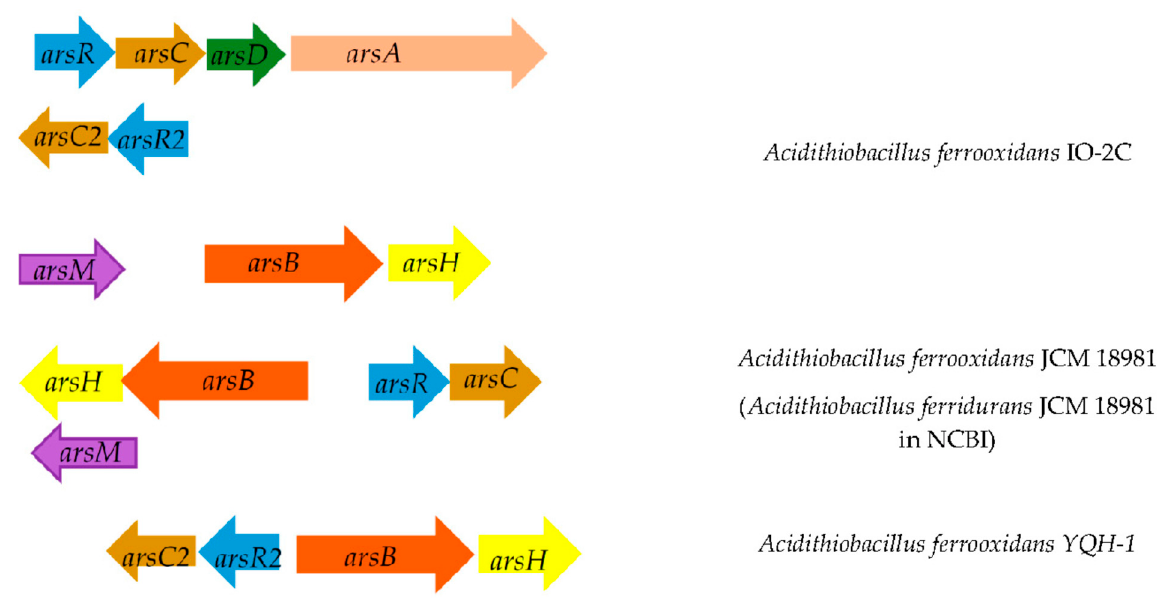
Figure 4. Location of arsenic resistance genes on the chromosome in various strains of A. ferrooxidans [60] (open access). The distance between genes is shown as bp scale. Genes encoding: arsB , arsenite/antimonite: H + antiporter; arsR , transcriptional repressor of the arsenic resistance operon; arsC , arsenate reductase; arsD , transcriptional repressor and arsenic metal chaperone.